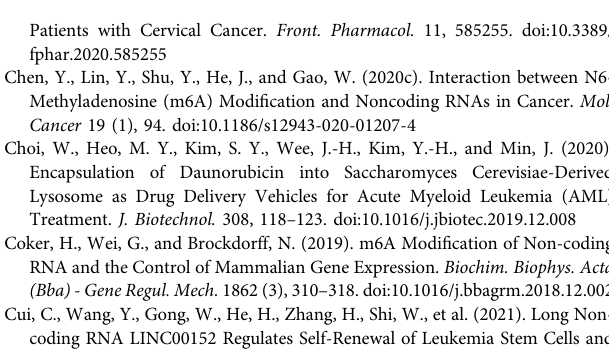
Supplementary Figure S1 | Kaplan – Meier survival curves for the 7 signature lncRNAs in AML. SupplementaryFigureS2| Themostpronounceddifferentialbiologicalprocesses between the high- and low-risk groups explored by GSEA. Supplementary Figure S3 | The correlation analysis between seven lncRNAs and 21 m6A genes. SupplementaryFigureS4| Theexpressionsof7signaturelncRNAsinpan-cancer from TCGA. Supplementary Figure S5 | The expressions of 7 signature lncRNAs in AML and normal tissues analyzed by GEPIA. Supplementary Table S1 | The clinical characteristics for AML cases. Supplementary Table S2 | Primer sequences for